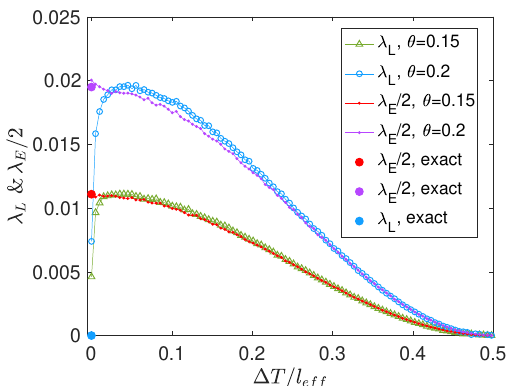
/ 2 and λ with the driving protocol 1 and with the E L